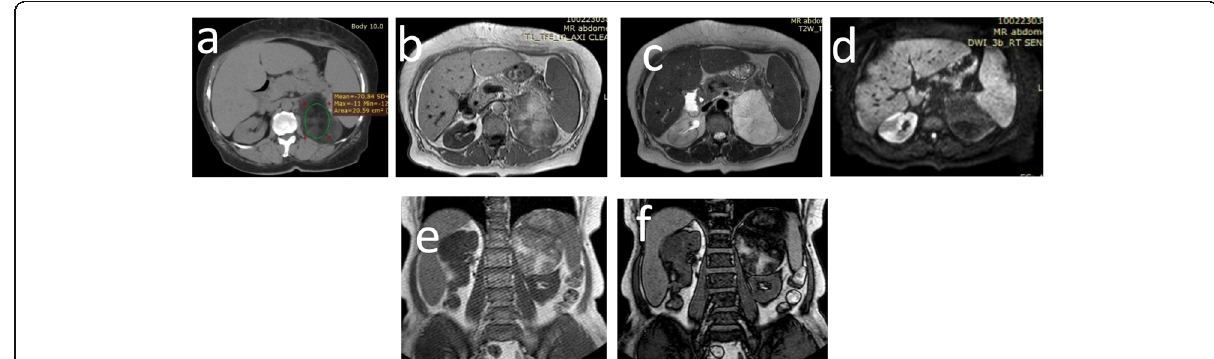
Fig. 8 A 50-year-old female patient known SLE with high creatinine level due to associated nephropathy came for a CTUT. a NECT of abdomen axial section showing left suprarenal soft tissue mass lesion measuring 10 cm in maximum axial dimension with heterogeneous attenuation with areas of pure fat content giving attenuation of − 70 HU. MRI abdomen adrenal protocol showing left suprarenal large soft tissue lesion with areas of high T1 ( b ) and less bright T2 signal ( c ) with facilitated diffusion ( d ). These areas show marked drop of signal. Diagnosis: left suprarenal